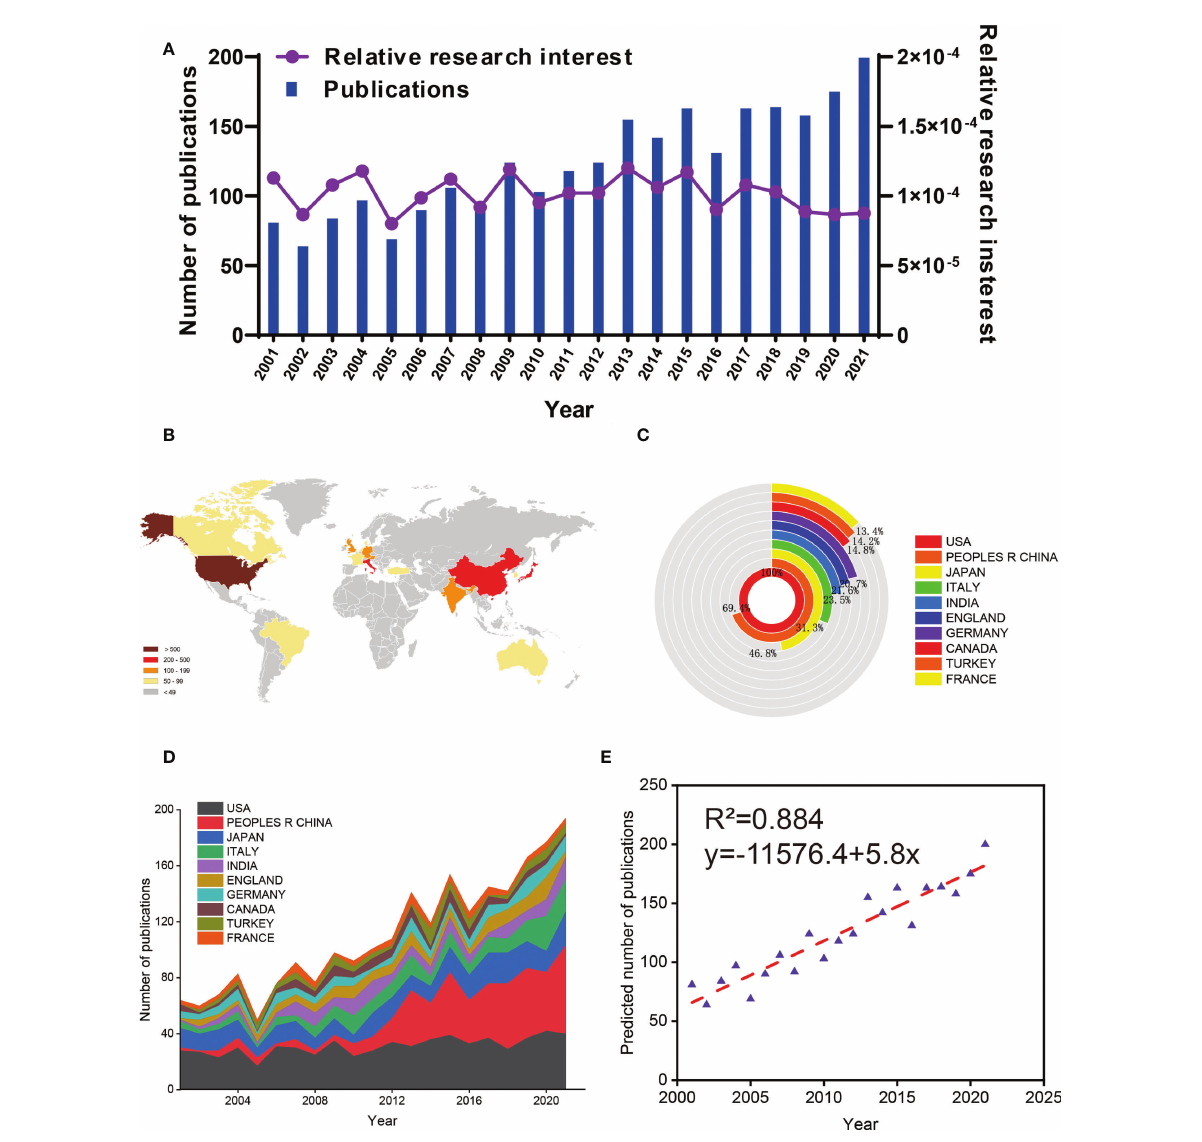
FIGURE 2 Global trends and countries/regions contributing to the research fi eld of GCTB. (A) The annual number of publications and related research interests related to GCTB. (B) A world map depicting the distribution of GCTB. (C) The annual number of publications in the top 10 most productive countries/regions from 2001 to 2021. (D) The sum of GCTB-related publications in the top 10 countries/regions. (E) Model fi tting curves of global trends in publications of/regions (R 2 =